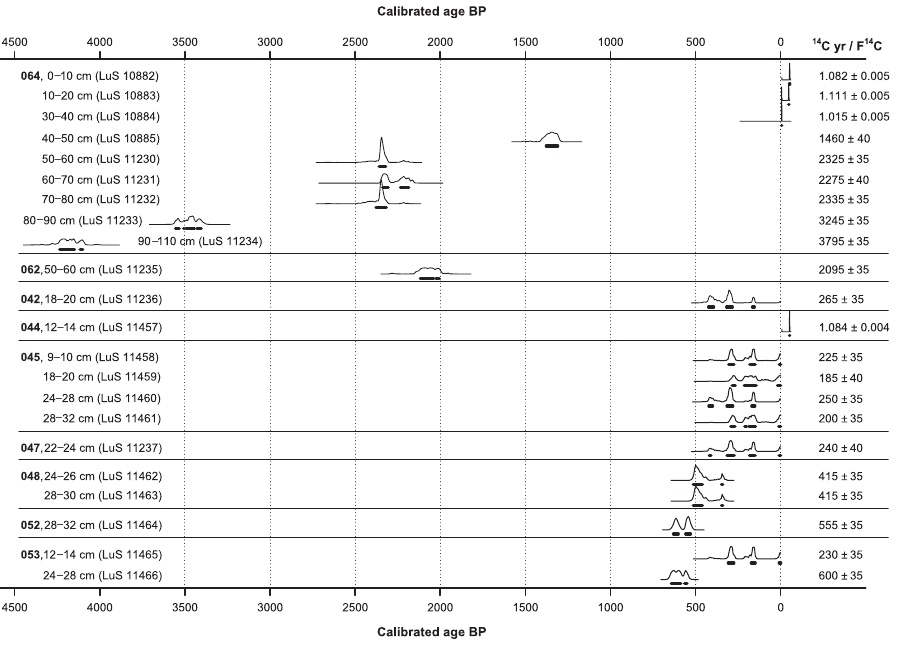
Figure 9. Calibrated age distributions for all 14 C dated soil and sediment samples. The thin line represents the probability distribution for each respective sample, and the thick black line shows the 1 σ age distributions. The column to the left gives the sample name followed by the laboratory sample number, while the numbers to the right are the uncalibrated 14 C dates (or F 14 C values for samples with a modern carbon composition) with their respective error